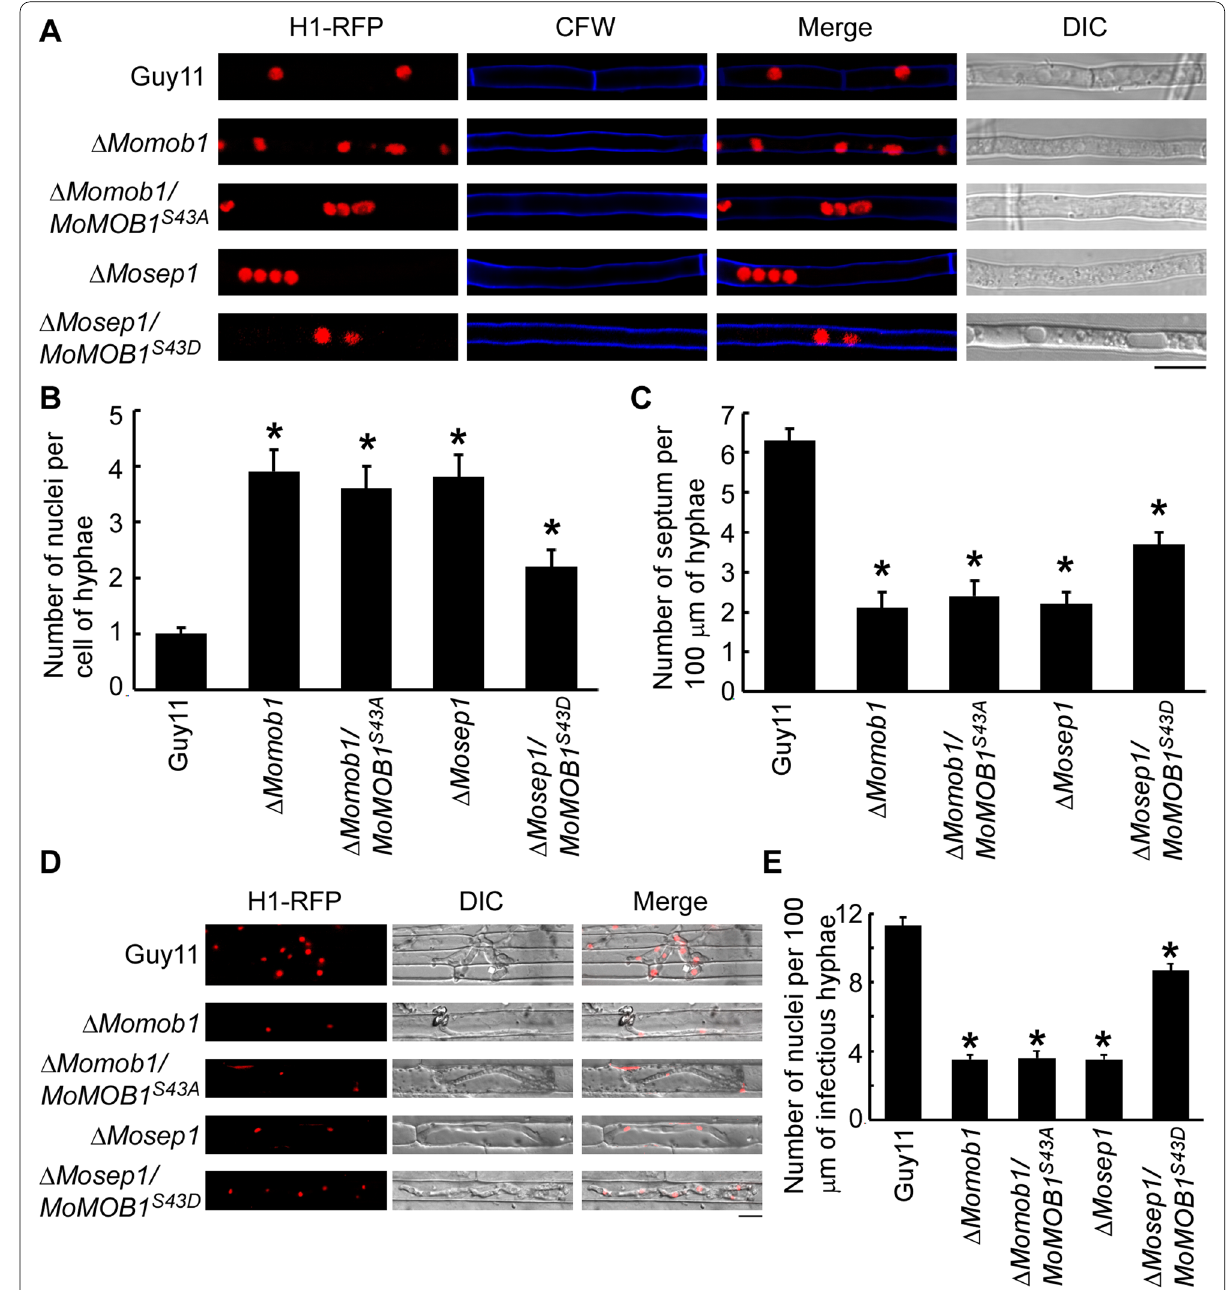
Fig. 6 MoSep1-dependent MoMob1 phosphorylation is important for MEN signaling in M. oryzae . A Hyphae from Guy11, Δ Momob1 , Δ Momob1/MoMOB1 S43A , and Δ Mosep1 , Δ Mosep1/MoMOB1 S43D strains expressing the H1-RFP construct were stained with CFW and examined by epif﻿luorescence microscopy. Bar, 10 μm. B Statistical analysis of nucleus number in hyphae. Error bars represent the standard deviations. Asterisks indicate statistical significances ( p < 0.01). C Statistical analysis of septum number per 100 μm hyphae. Error bars represent the standard deviations. Asterisks indicate statistical significances ( p < 0.01). D Infectious hyphae of Guy11, Δ Momob1 , Δ Momob1/MoMOB1 S43A , and Δ Mosep1 , Δ Mosep1/ MoMOB1 S43D mutants expressing the H1-RFP construct examined by epif﻿luorescence microscopy. Bar, 10 μm. E Statistical analysis of the number of nuclei per 100 μm infectious hypha in ( D ). Error bars represented the standard deviations. Asterisks denote statistical significances ( p <